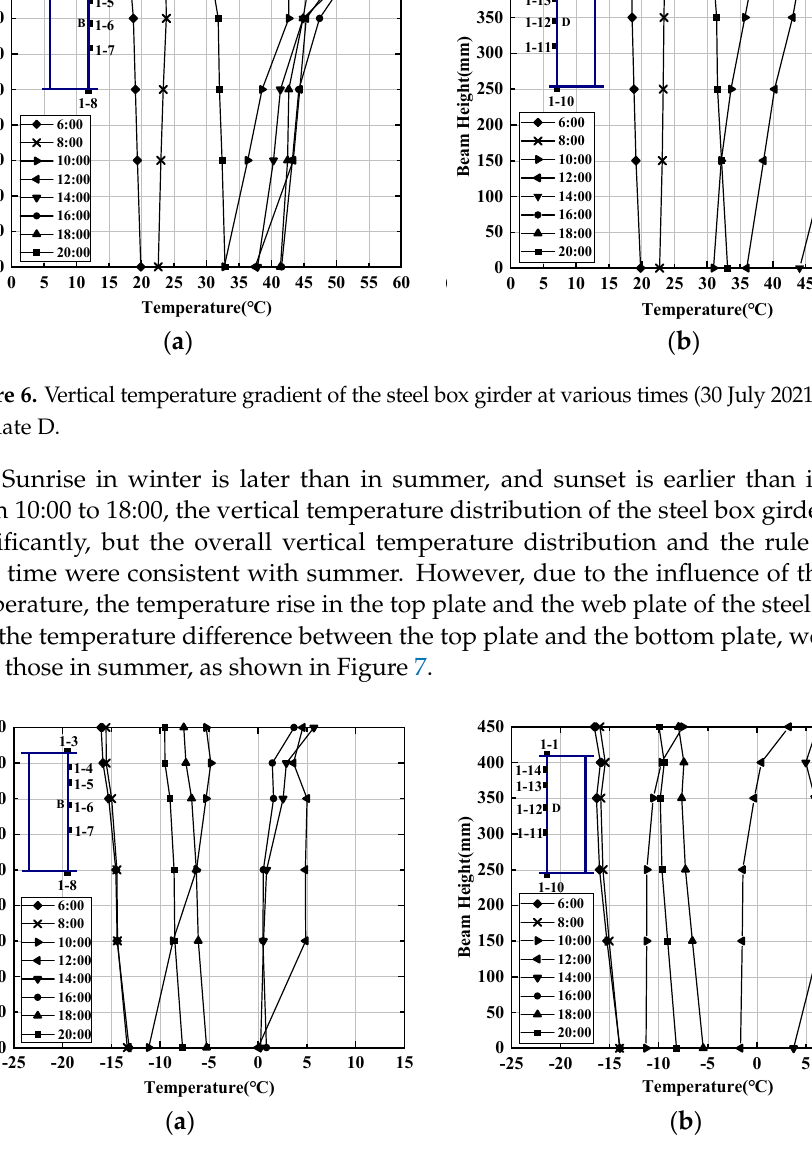
Figure 7. Vertical temperature gradient of the steel box girder at various times (26 December 2021). ( a ) Plate B; ( b ) plate D.